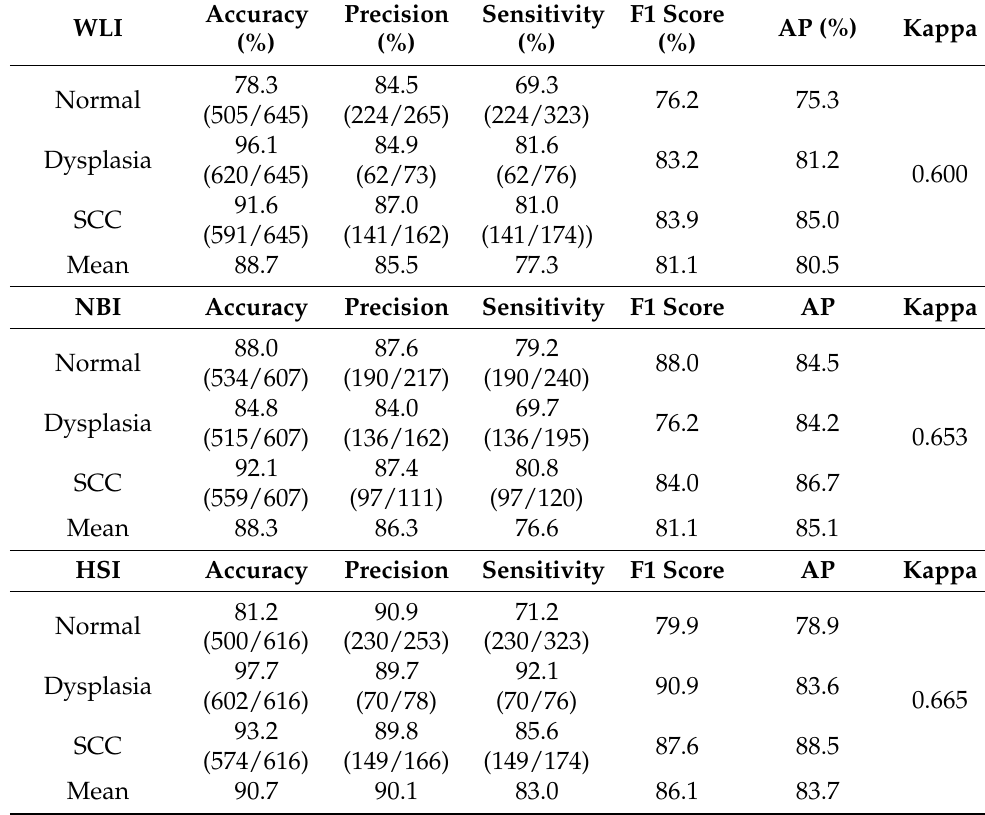
Table 1. Predicted performance results of the three developed